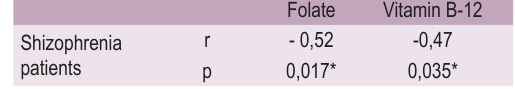
* Statistical signifi cant for